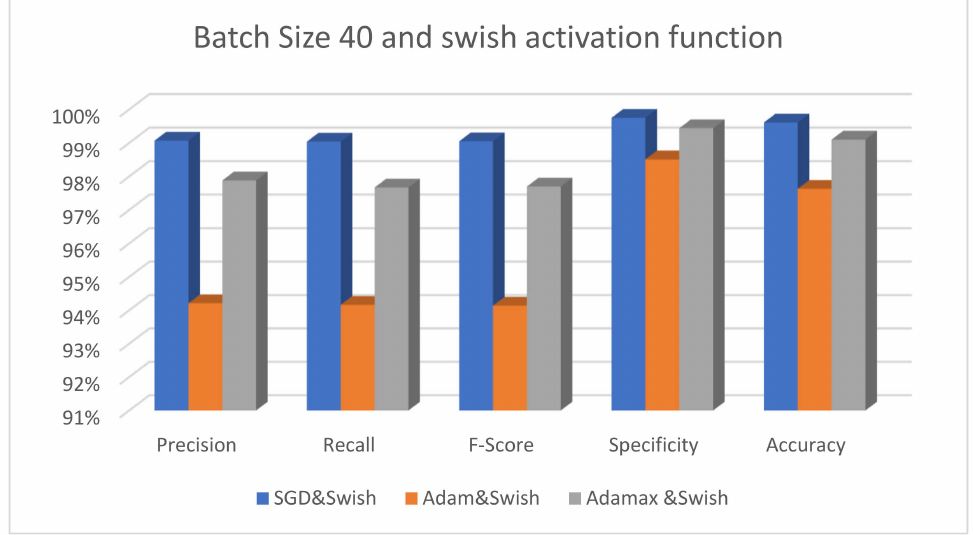
Figure 5. The performance of the ResNet101 model with different optimizers using batch size 40 and the Swish activation function.